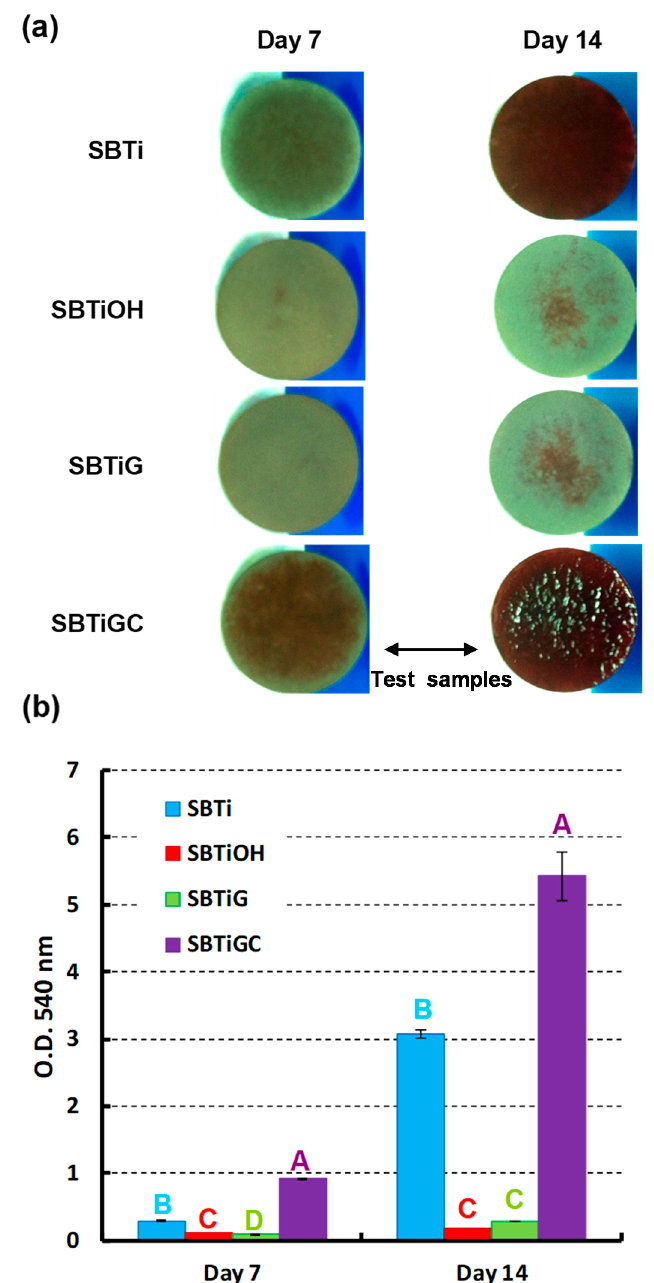
Figure 6. ( a ) Qualitative and ( b ) quantitative data pertaining to mineralization of hMSCs based on Alizarin red S staining analysis following incubation for 7 or 14 d (groups with different letters are Scheme 0.